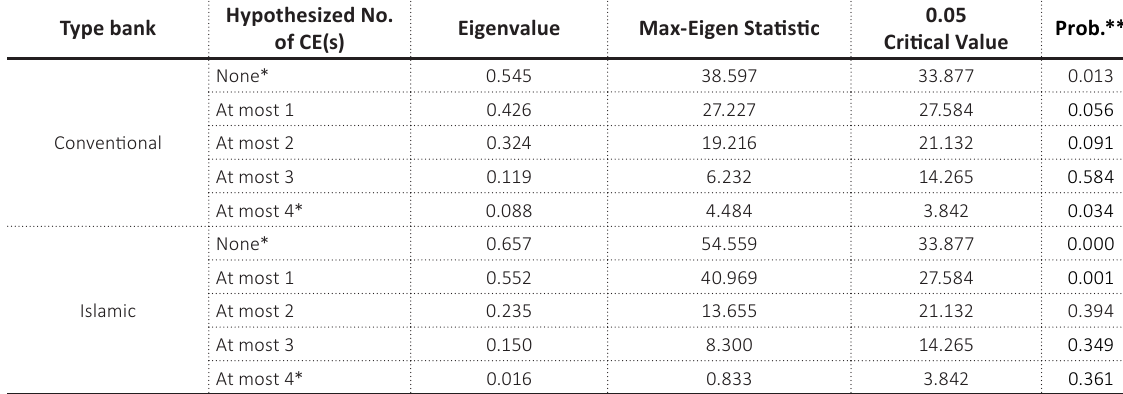
Table A4. Cointegration test result